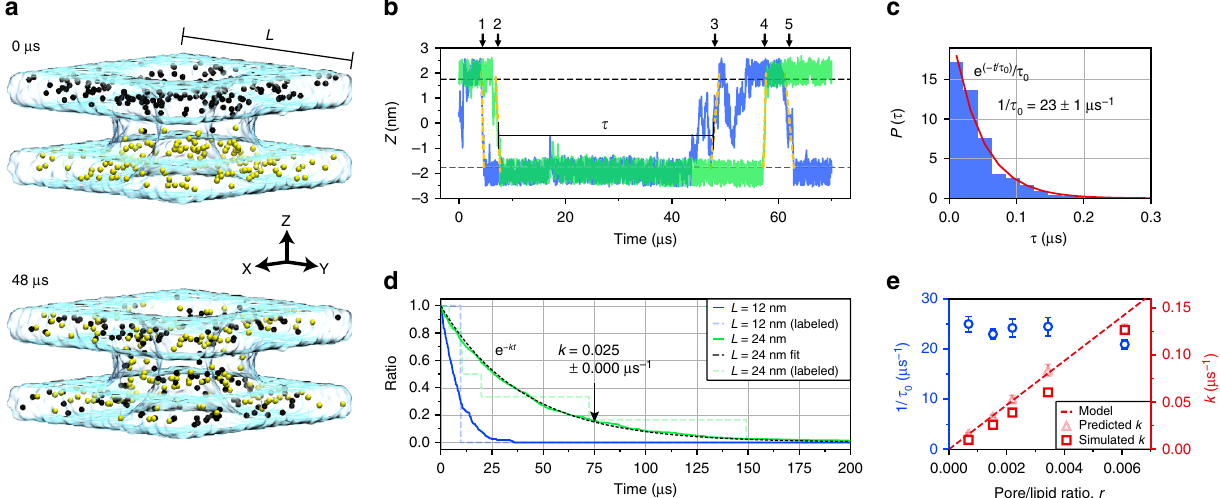
Fig. 3 BD simulation of lipid scrambling. a Distribution of lipid head groups at the beginning (0 µ s) and after 48 µ s of BD simulation. Black and yellow spheres represent lipid head groups initially located in the upper and lower bilayer lea fl ets, respectively. The cyan semi-transparent surface schematically illustrates the volume accessible to lipid head groups during the simulation; L denotes the size of the lipid patch (here L = 12 nm). b Z coordinates of two representative lipid head groups. Horizontal dashed lines (at Z = ±1.75 nm) indicate approximate boundaries of upper and lower lea fl ets. The traces feature fi ve inter-lea fl et transfer events; τ de fi nes the interval between two consecutive events. Head group trajectories were sampled every 2.4 ns. c Normalized probability of observing an inter-lea fl et transfer event within time interval τ . An exponential fi t (red line) yields the average transfer rate 1 / τ 0 = 23.0 ± 1.03 µ s − 1 . Data were obtained from a 500 µ s trajectory of the L = 24 nm system sampled every 2.4 ns. d Fraction of lipid head groups remaining in the upper bilayer lea fl et vs. time elapsed from the beginning of the simulation. Data are shown for two systems differing by the size of the lipid patch. Lipids reentering the lea fl et were not included in the fraction calculation. The black dashed line shows an exponential fi t to the curves; the fi tting parameter k is the scrambling rate. Dashed lines plot the same quantity for randomly chosen lipids mimicking experimental conditions where only a small amount of fl uorescently labeled lipids is used to assess lipid scrambling. e Simulated transfer rate (left axis) and scrambling rate (right axis) vs. pore-to-lipid ratio. Data were derived from BD simulations of systems of different lipid patch size ( L = 12, 16, 20, 24, and 36 nm). Scrambling rate extracted directly from the simulation is plotted using squares. Dashed line plots k = r / 〈 τ 0 〉 curve; transparent triangles indicate k = r / τ 0 , where 1 / 〈 τ 0 〉 and 1 / τ 0 are system-size- averaged and system-size-speci fi c lipid transfer rates, respectively. Error bars indicate standard